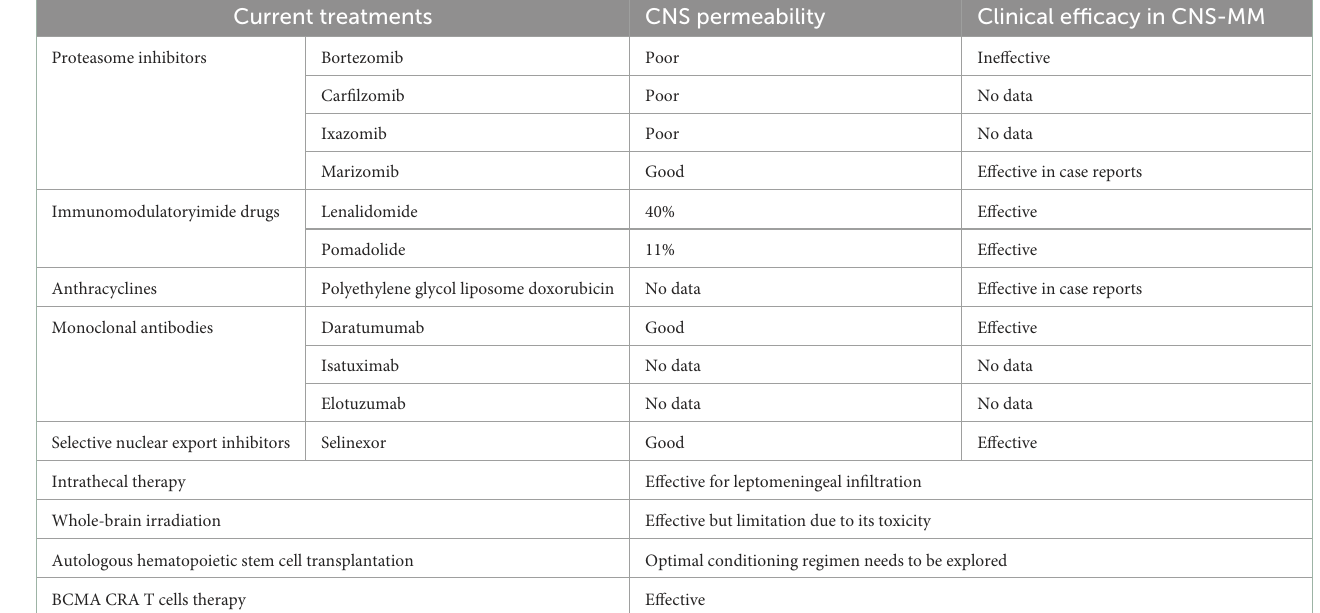
TABLE 1 The current treatments for CNS-MM. Current